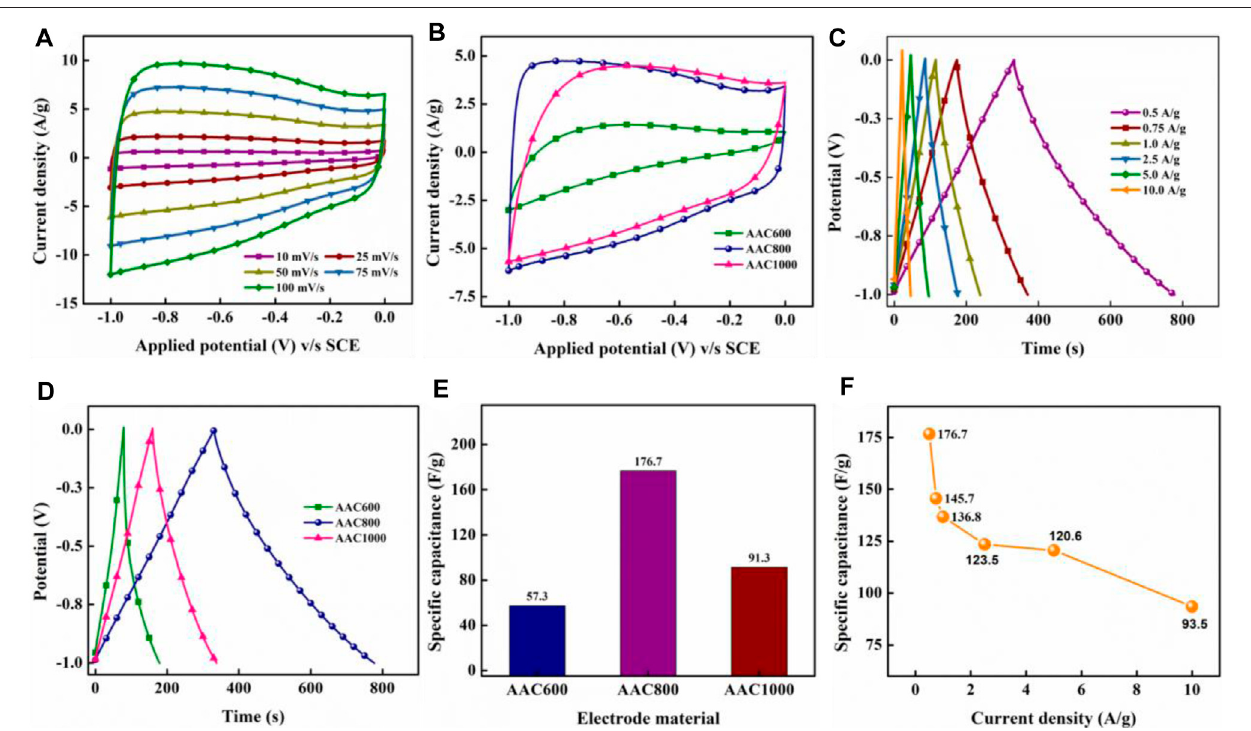
FIGURE 6 | CV of the AAC800 electrode at different scan rates (A) , comparative CV pro fi le of all AACs in 50 mV/s (B) , GCD curve of AAC800 at different current densities (C) , comparative GCD pro fi le of AACs at 0.5 A/g (D) , speci fi c capacitance of AACs at 0.5 A/g (E) , and speci fi c capacitance of the AAC800 electrode as a function of current density (F)